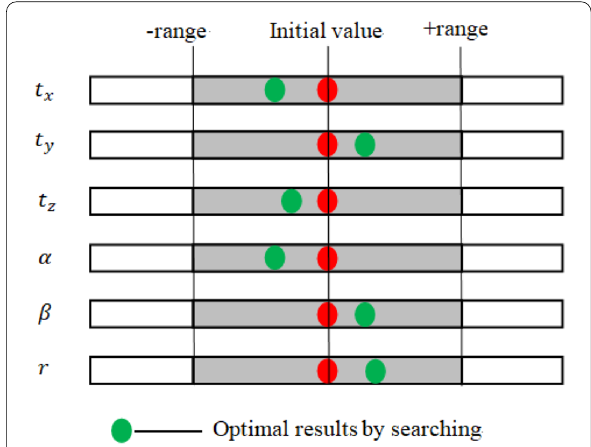
Figure 4 Different coordinates of the sphere center in the laser plane for building “conjugate pairs”